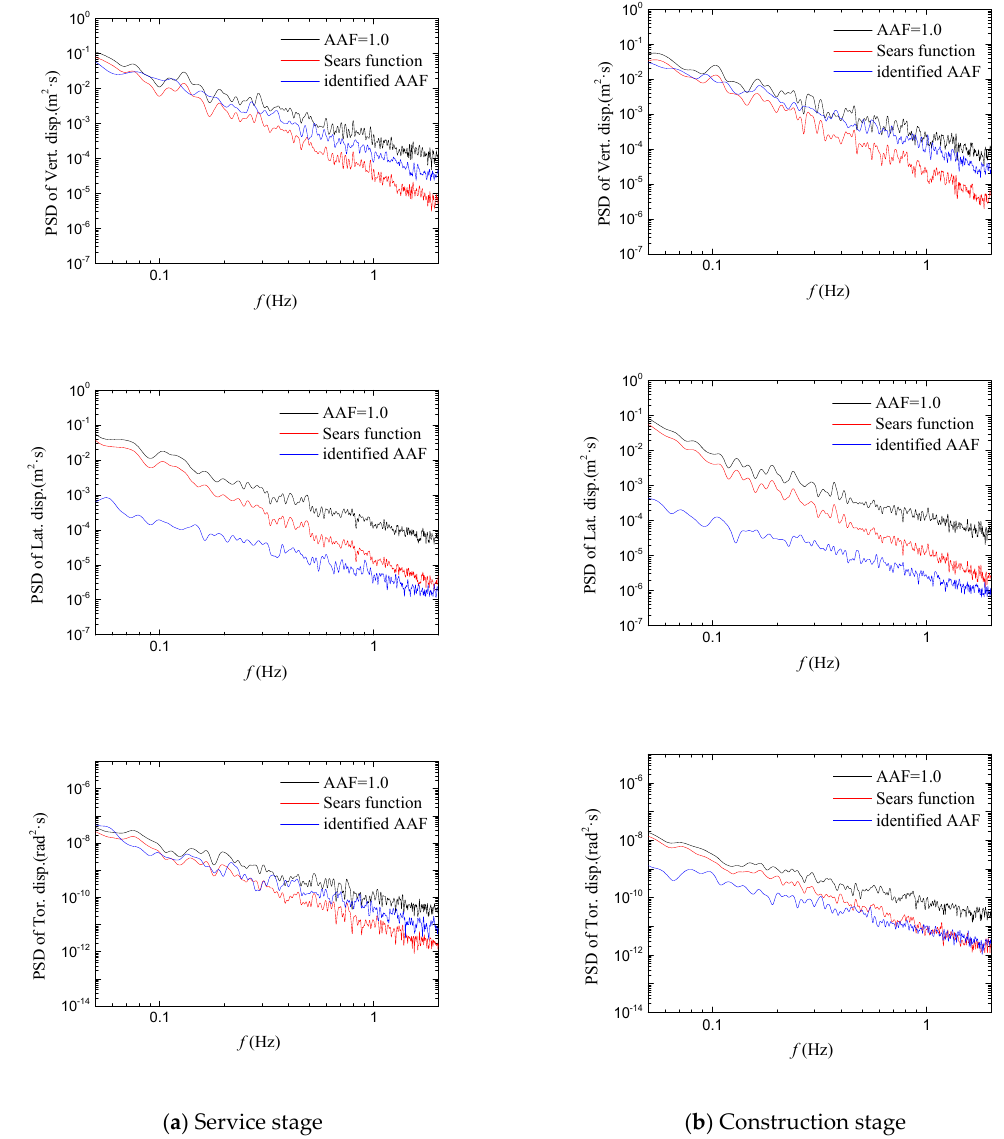
Figure 20. Buffeting response PSDs at the mid-span centre point under different AAFs. Figure 20. Bu ff eting response PSDs at the mid-span centre point under di ff erent